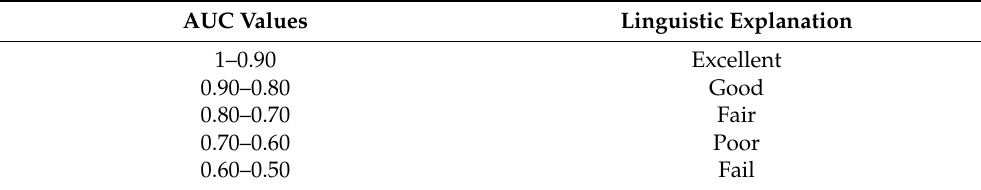
Table 3. The linguistic representation of the area under the curve